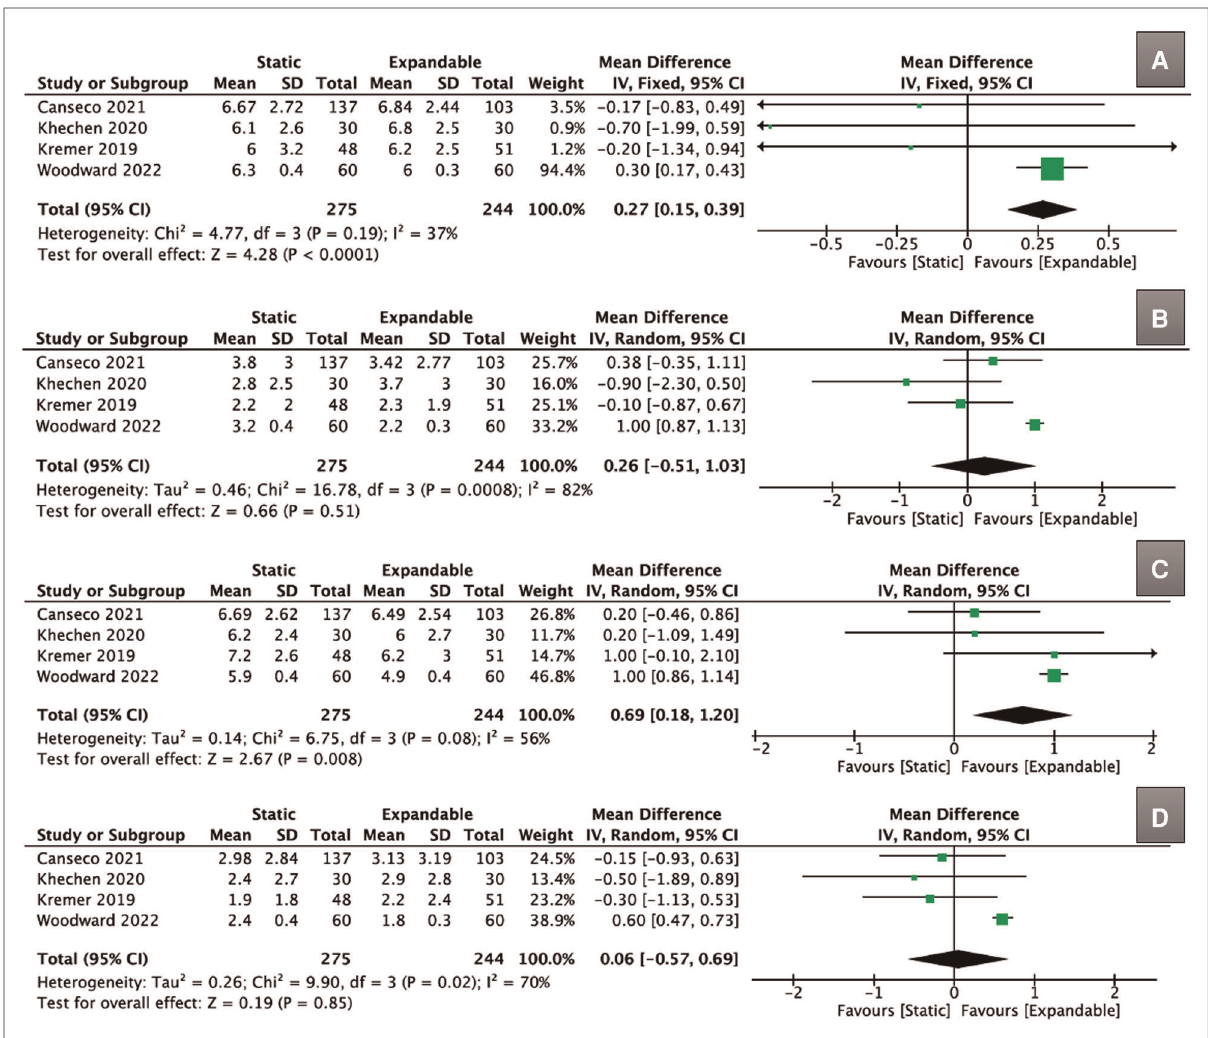
FIGURE 10 Forest plots for comparison of VAS for back at preoperative ( A ) and fi nal follow-up ( B ) between the static and expandable groups. Forest plots for comparison of VAS for leg at preoperative ( C ) and fi nal follow-up ( D ) between the static and expandable groups.VAS: visual analog